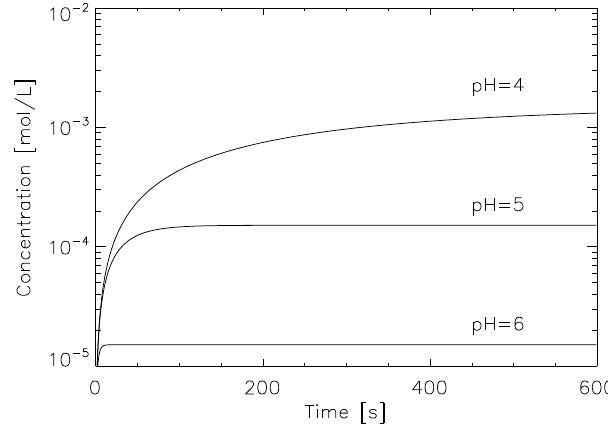
Figure 7. The equilibrium gas phase ammonia mixing ratio, cal- culated with E-AIM, as a function of the ammonium to sul- phate ratio of the aerosol. Data shown are for − 10 and 10 ◦ C, at RH = 95%.